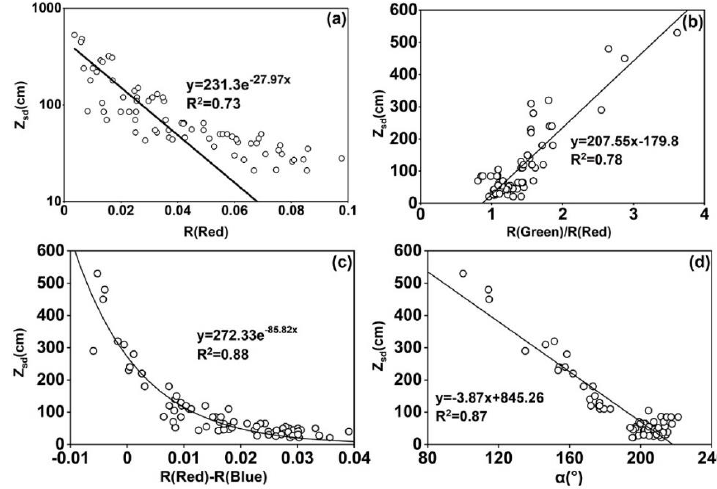
Table 5. Z sd model accuracy test.